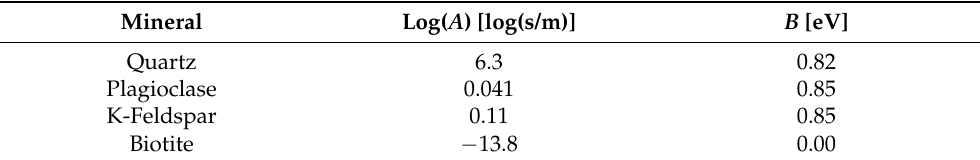
Table 2. Values of the empirical parameters [12].